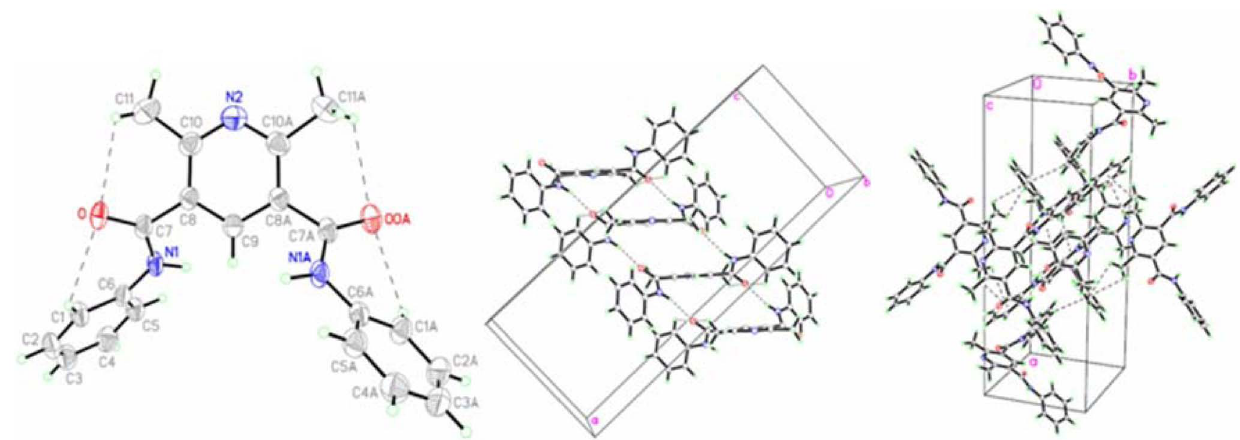
Figure 2. Crystal structure of a.